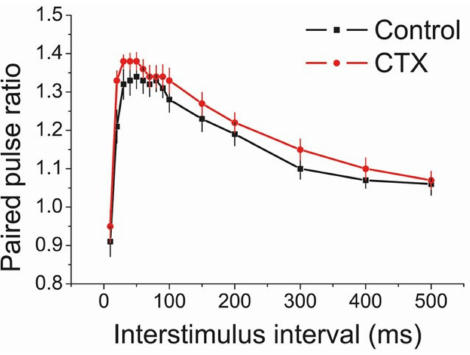
Figure 4. There is no e ff ect of ceftriaxone (CTX) treatment on short-term facilitation measured at di ff erent interpulse intervals in the CA1 area of the